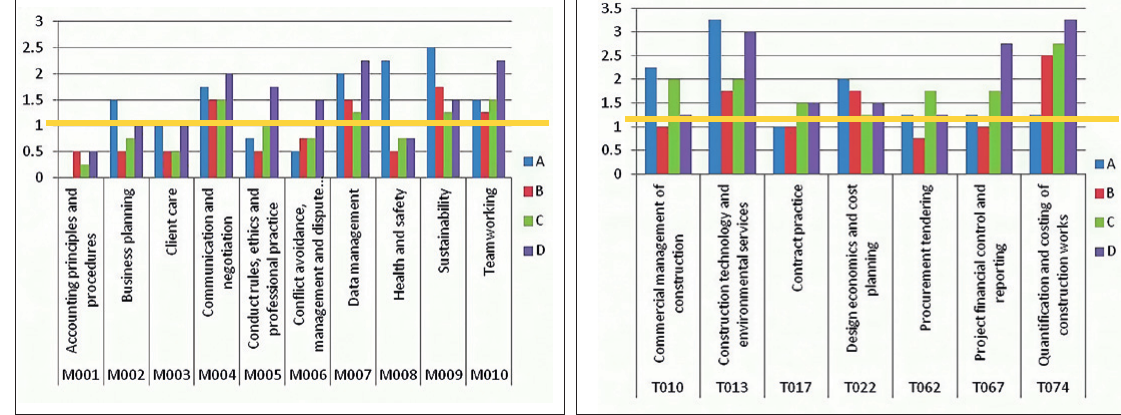
Figure 3. Mandatory competency mapping scores: Figure 4. Core competency mapping scores: